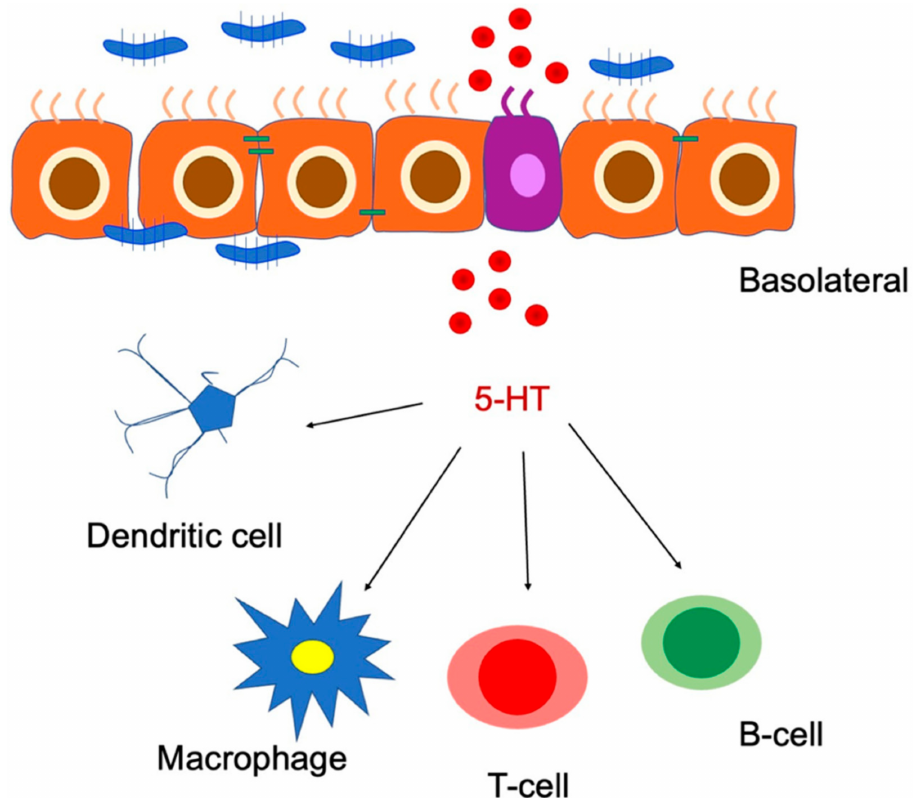
Figure 11. Schematic representation of the role of 5-HT in immune cell activation and gut inflamma- tion. 5-HT: 5-hydroxytryptamine. Modified from Banskota et al. (2019)